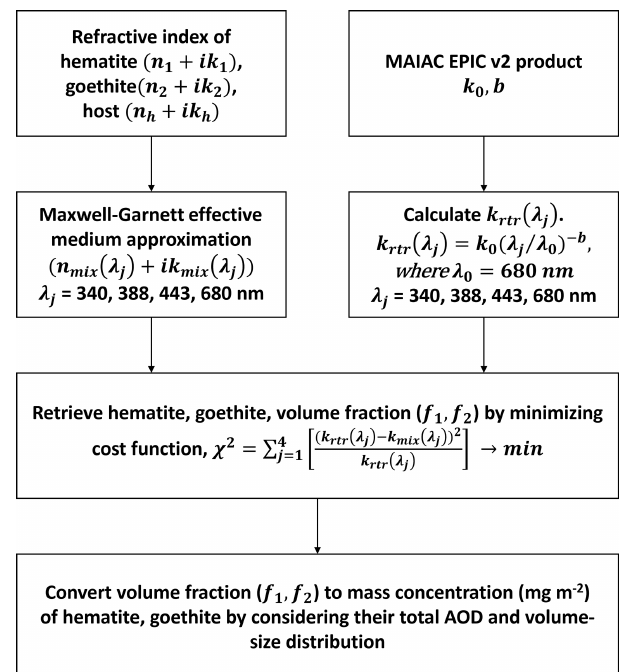
Figure 2. Schematic diagram of the methodology of this study. Spectral aerosol absorption data from MAIAC EPIC ( b and k 0 val- ues) are used to infer imaginary refractive indices ( k rtr ) at 340, 388, 443, and 680nm. These values are fitted with imaginary indices of mixtures with hematite, goethite, and the host complex refractive index using the Maxwell Garnett effective medium approximation rule. The cost functions between the EPIC imaginary and mixture refractive indices are minimized by iteration of the volume fractions ( f ) of hematite and goethite (Sect.